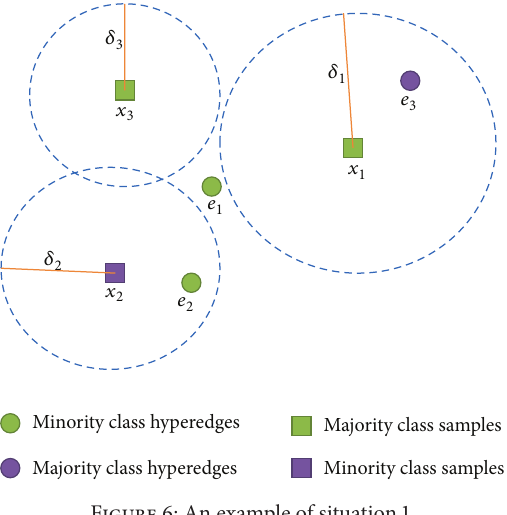
Figure 6: An example of situation